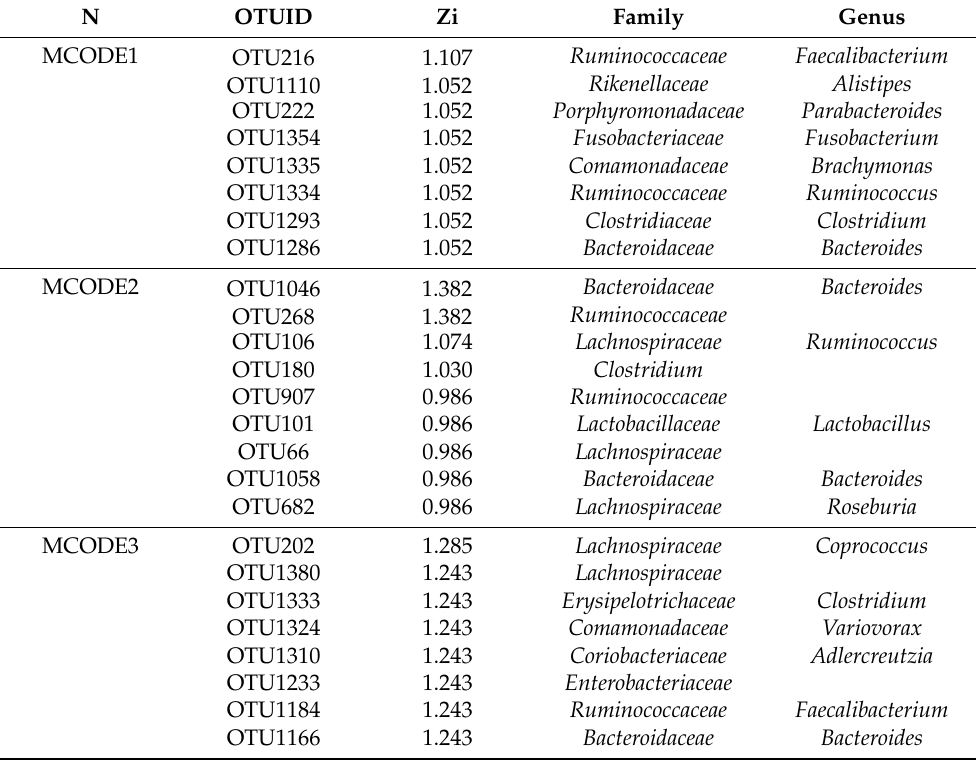
Table A8. Core colonies and corresponding Zi values in each module of N group in network analysis.